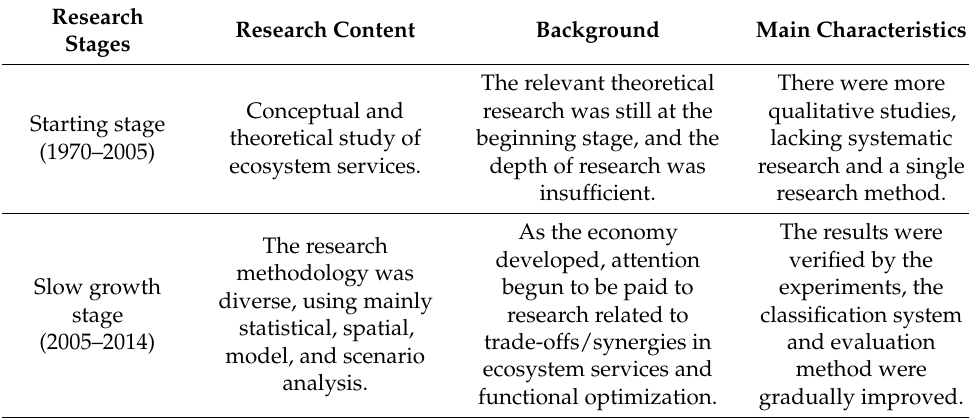
Table 1. Division of the research stages.